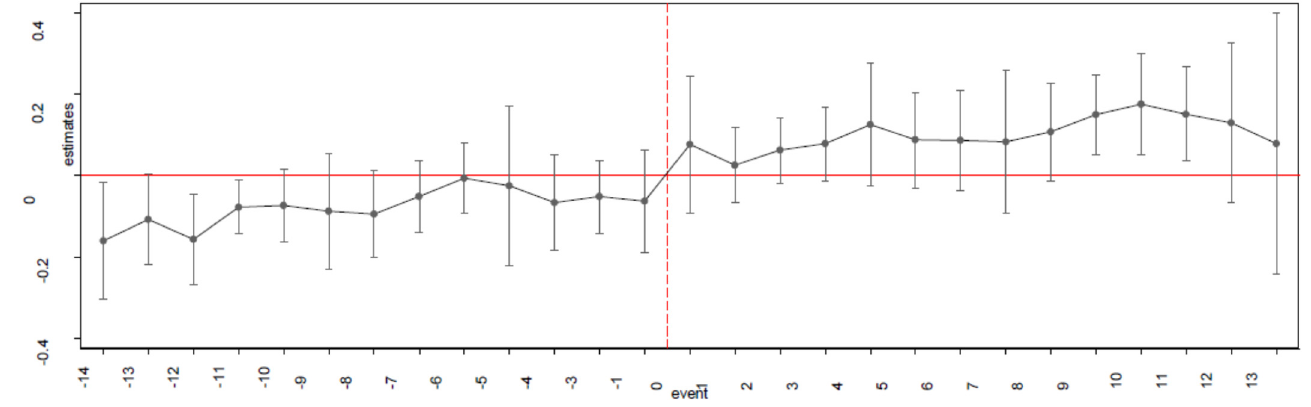
Figure 4. Parallel Trends Analysis—Event Study on Loans